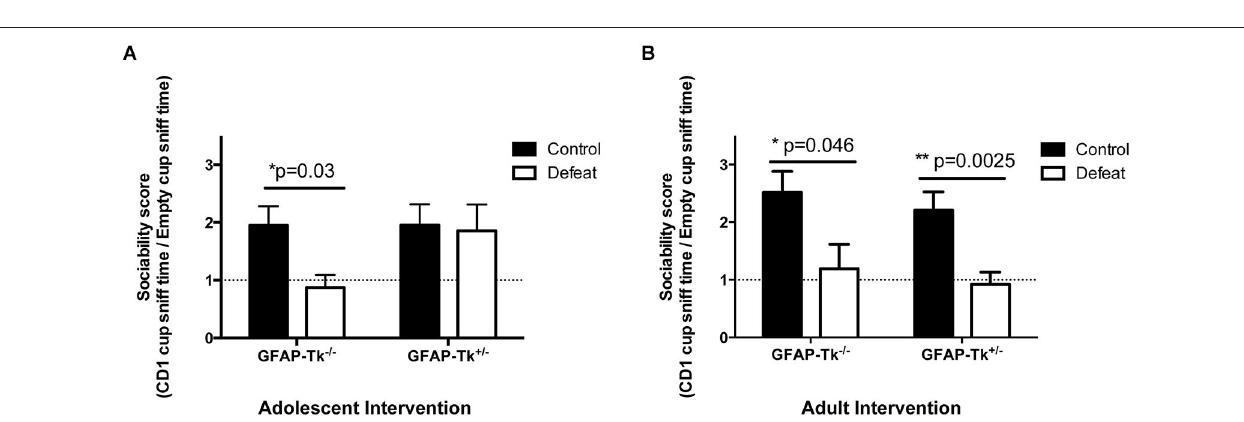
show reduced sociability scores following social defeat compared to naïve mice indicating susceptibility. Bars represent mean ± SEM, for adolescent cohort GFAP-Tk − / − control n = 8, GFAP-Tk − / − defeat n = 8, GFAP-Tk + / − control n = 8, GFAP-Tk + / − defeat n = 8. Adult cohort GFAP-Tk − / − control n = 8, GFAP-Tk − / − defeat n = 9, GFAP-Tk + / − control n = 10, GFAP-Tk + / − defeat n =